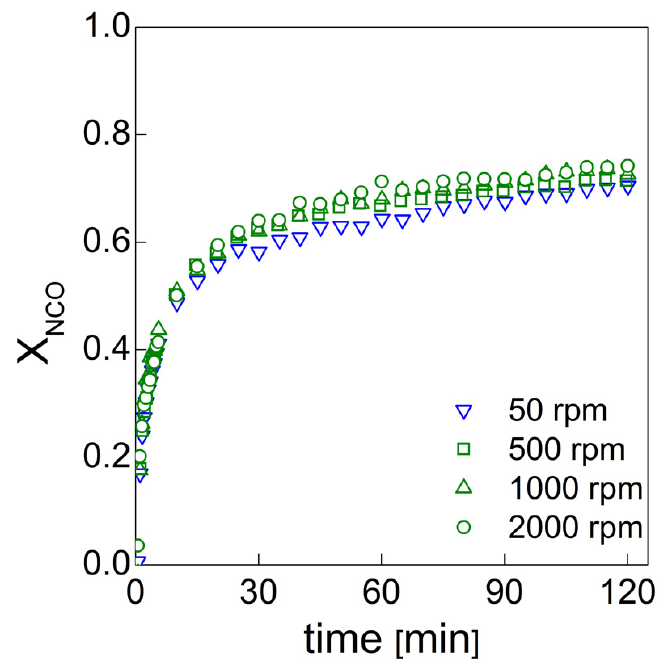
Figure 9. Isocyanate conversion as a function of time for the systems obtained at the different mixing speeds. Table 5. Effects of mixing speed on NCO conversion: results of the fitting procedure.